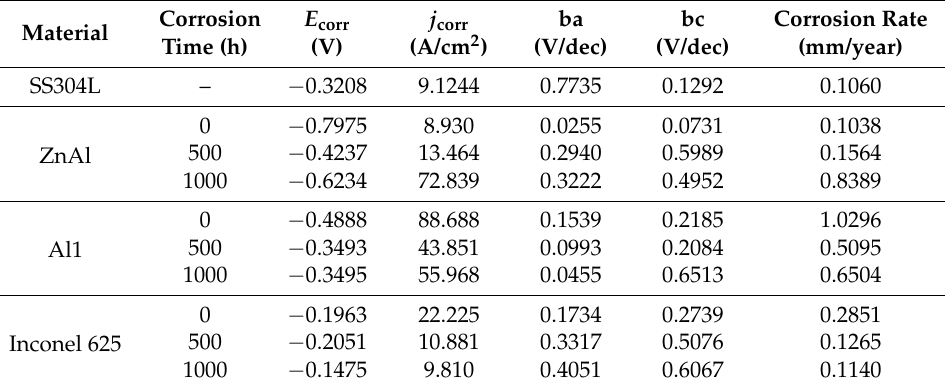
Table 5. Tafel analysis parameters for the NaCl deposition